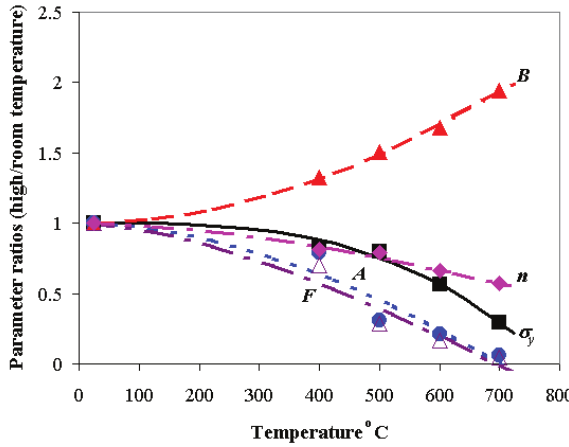
Figure 7. Fitting curves based on the relationship of mate- rial parameters and temperatures with more